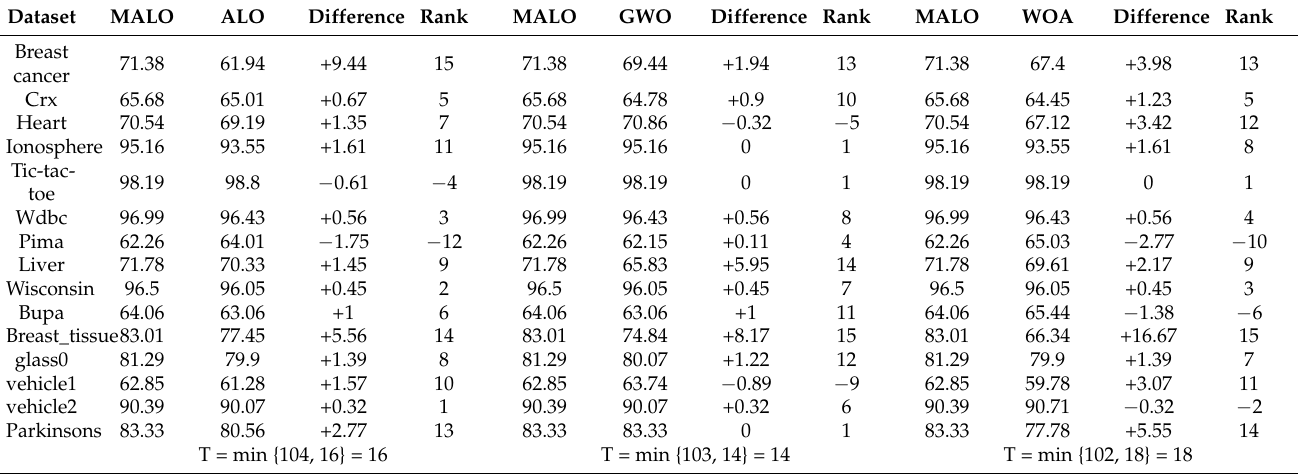
Table 13. Significance test of average auc between MALO vs. ALO, MALO vs. GWO, and MALO vs. WOA.